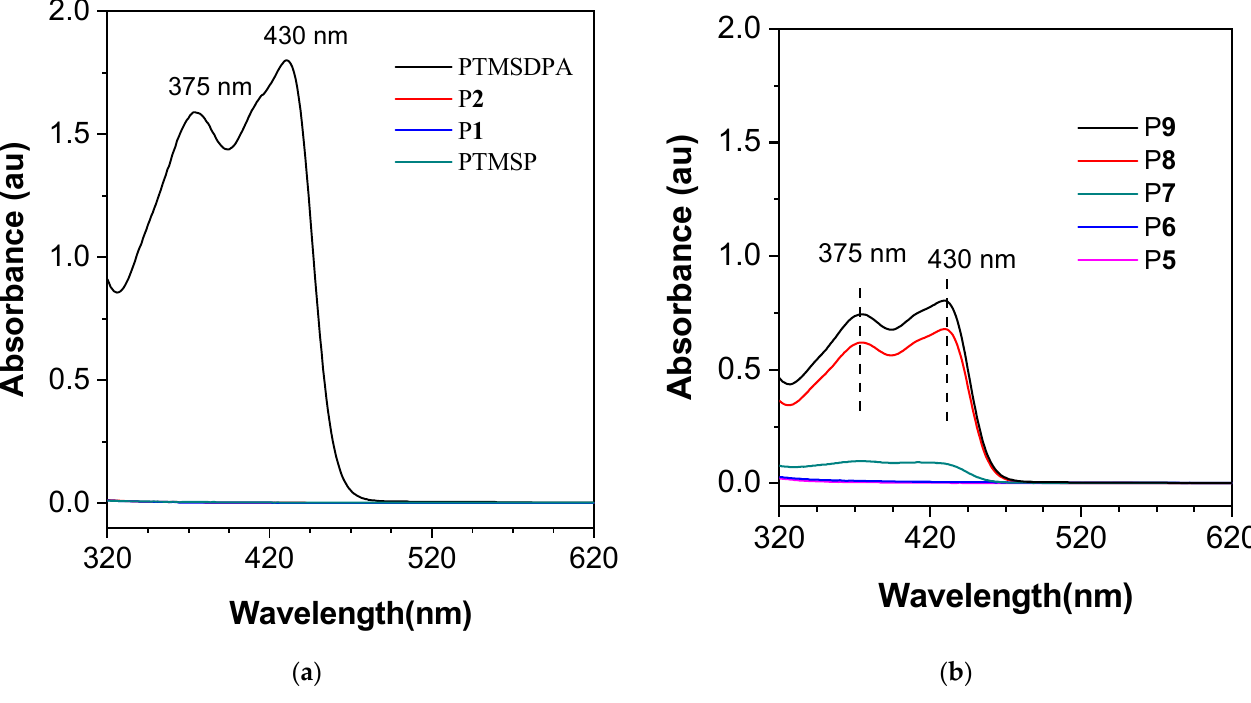
Figure 3. ( a ) UV-vis spectra of PTMSP, P 1 , P 2 , and PTMSDPA. ( b ) UV-vis spectra of P 5 , P 6 , P 7 , P 8 , and P 9 .